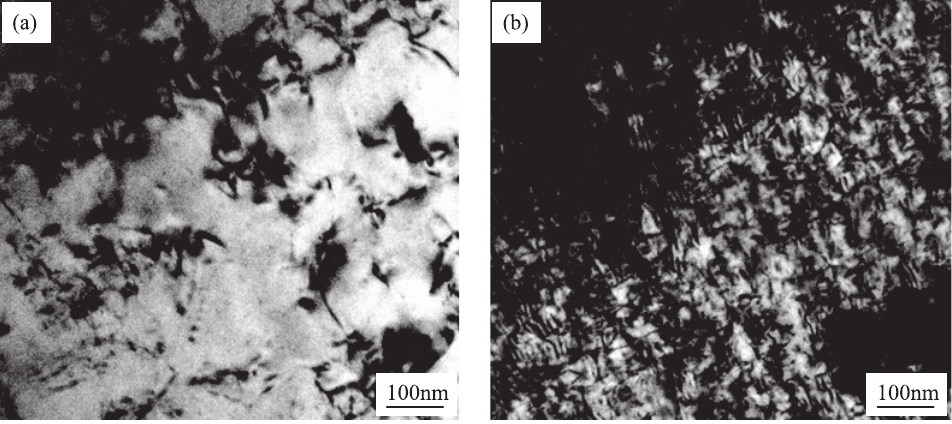
Fig. 3: TEM images of the CuZn alloy before and after high pressure treatment. (a) Original; (b) after 3 GPa treatment